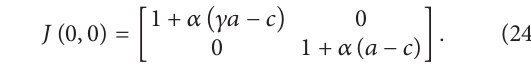
Figure 1: Starting from the red (resp., black) region, the first iterate is (0, 𝑞 2 ) , with 𝑞 2 > 0 (resp., (𝑞 1 , 0) , with 𝑞 1 > 0 ). The yellow lines are the best reply curves of the two firms. The solid blue line represents points in which 𝑝 = 0 . The dotted and dashed blue lines represent trajectories that start from the red and black regions, respectively, and end up to the Nash equilibrium. Parameter set: 𝑎 = 2.8 , 𝑏 = 1 , 𝑐 = 1 , and 𝛾 = 0.7